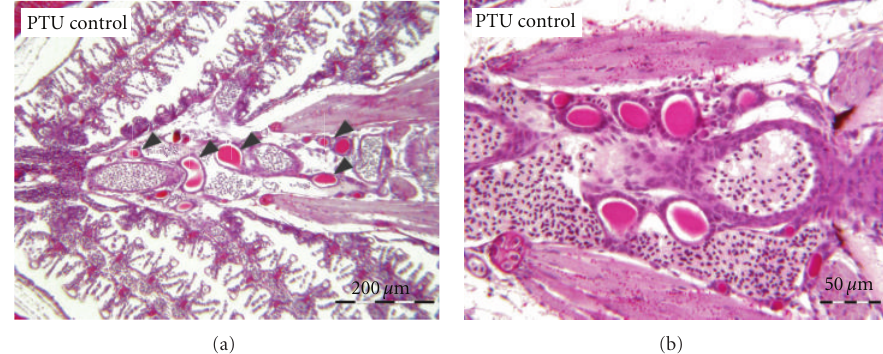
Figure 5: Representative histological pictures of thyroidal tissue in the control zebrafish ( Danio rerio ). The isolated thyroid follicles are distributed adjacent to the ventral aorta in the gill region. Follicular shape is spherical to oval with a cuboidal epithelium and a homogeneously stained colloid. Sections of 2 μ m thickness stained with periodic acid-Schi ff (PAS) and Mayer’s